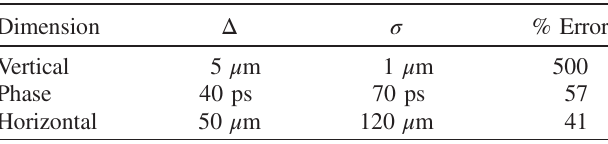
TABLE III. Summary of the typical alignment accuracy Δ and the percentage of the nominal approximate size σ in each